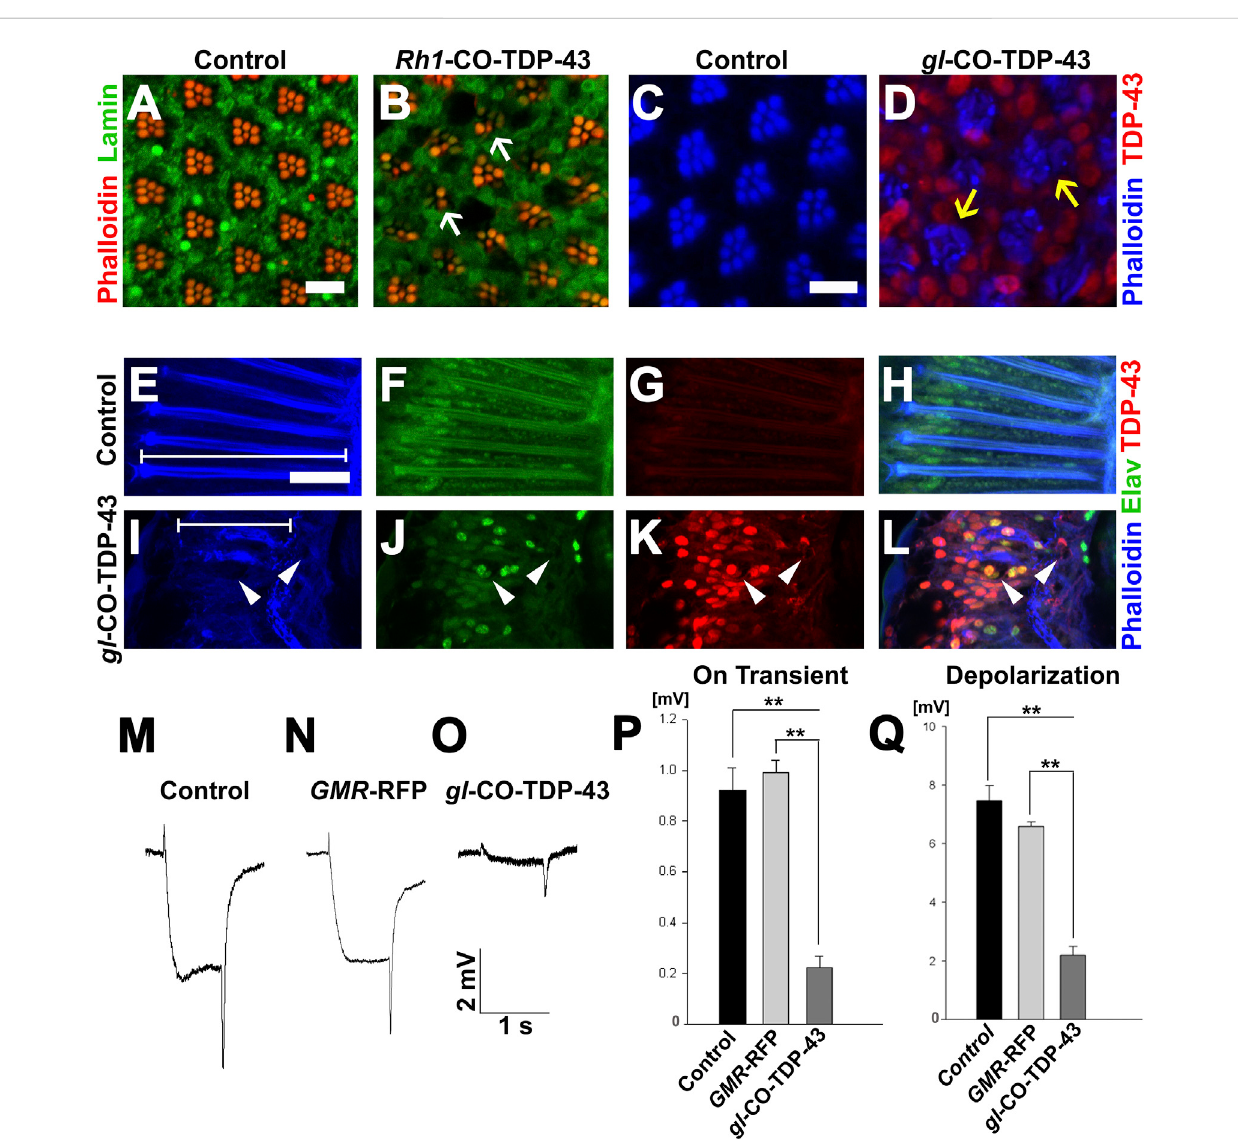
FIGURE 4 TDP-43 misexpression in adult retina causes degeneration and altered morphology of the photoreceptor neurons. (A) UAS -LacZ and (B) UAS -CO- TDP-43 expressed in the retina using Rh1 -GAL4 that selectively expresses TDP-43 in R1-R6 photoreceptor neurons during the late pupal stage. Compared to control, the CO-TDP-43 shows loss of rhabdomeres (white arrows) and degeneration in the 7 days post-eclosion adult retina (scale bar 5 µm).The gl -CO-TDP-43 fl ies (D) exhibitrhabdomereseparationdefectand fl attenedstructuresoftherhabdomeres(yellowarrows)in1-daypost- eclosion adult compared to GMR -GAL4 control (C) , as seen in the tangential view of the retina (scale bar 5 µm). Similarly, in the longitudinal view, the gl - CO-TDP-43 fl ies (I – L) show altered photoreceptormorphology that appear to beshorter [whitelines in( E, I )compared to control (E – H) ]. The CO-TDP- 43 fl ies also contain large vacuoles (white arrowheads) in 1-day post-eclosion adult retina (scale bar 10 µm). (M – O) ERG traces of wild-type control, GMR -RFPcontroland gl -CO-TDP-431-daypost-eclosionadults,respectively,areshown.Quanti fi cationoftheERGresponseamplitudeforontransient (P) and depolarization (Q) , along with the traces, show that CO-TDP-43 fl ies have decreased responses for both measures. For on transient effect, n = 15and p < 0.001betweenbothgroups (P) ,andfordepolarizationeffect, n =15and p < 0.001betweenbothgroups (Q) .Genotypes: (A) w 1118 /+; Rh1 -GAL4/ +; UAS-LacZ/+, (B) w 1118 /+; Rh1 -GAL4/UAS-TDP-43 CO ;+, (C) Canton S, (D) w 1118 ; gl -TDP-43 CO /+; +, (E – H) Canton S, (I – L) w 1118 ; gl -TDP-43 CO /+; +, (M) Canton S, (N) w 1118 ; GMR -GAL4/+; UAS-RFP/+, (O) w 1118 ; gl -TDP-43 CO /+;